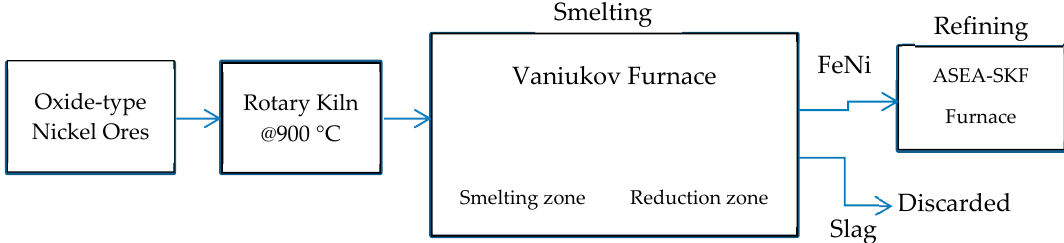
Figure 1. Flowsheet of the Vaniukov process.